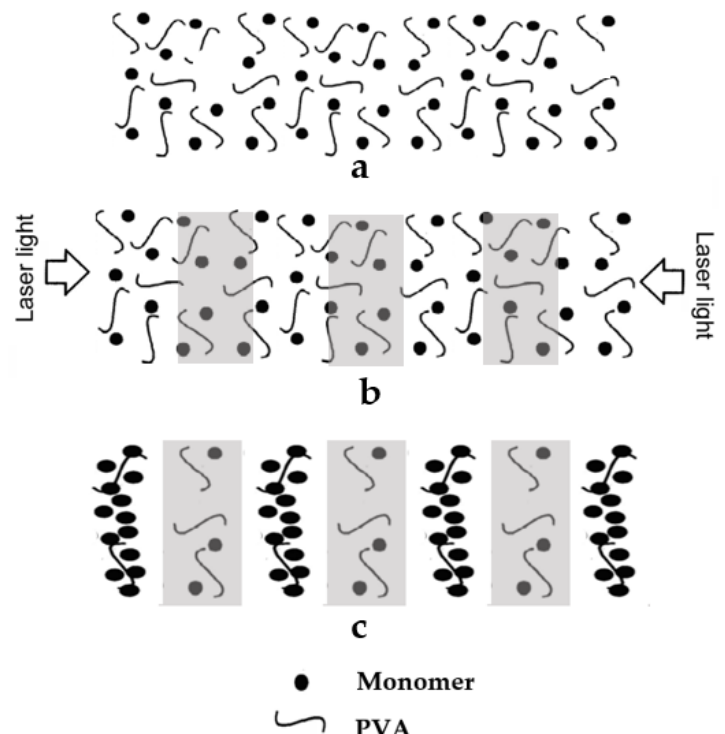
Figure 2. Schematic of the photopolymerisation process in a photopolymer layer during hologram recording: ( a ) photopolymer layer before exposure to laser light; ( b ) exposure to light; ( c ) photopolymer layer after light exposure.